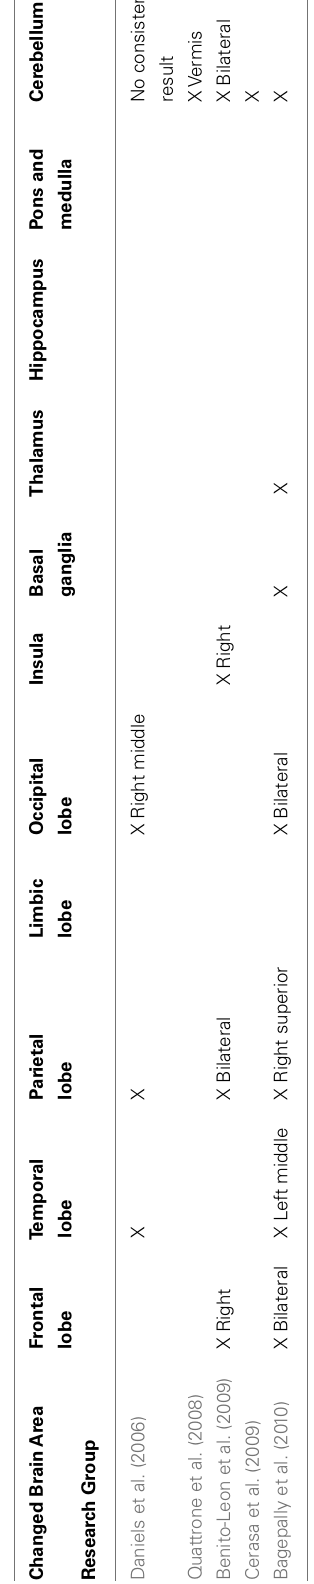
Table 3 | Demographic characteristics and clinical assessment scores in PD, ET, and healthy